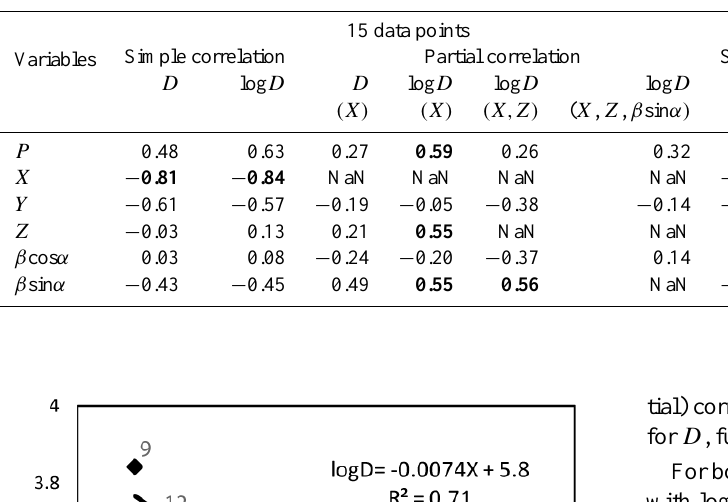
Table 2. Pearson correlation coefficients and partial correlation coefficients of chloride deposition D and log D with selected variables for the data sets of 15 sites and 17 sites. ( P is long-term mean annual precipitation, other symbols are described in Eq. (5), the correlation coefficients in bold face are significant above 99.9% confidence level for simple correlation, and above 95% for partial correlation).